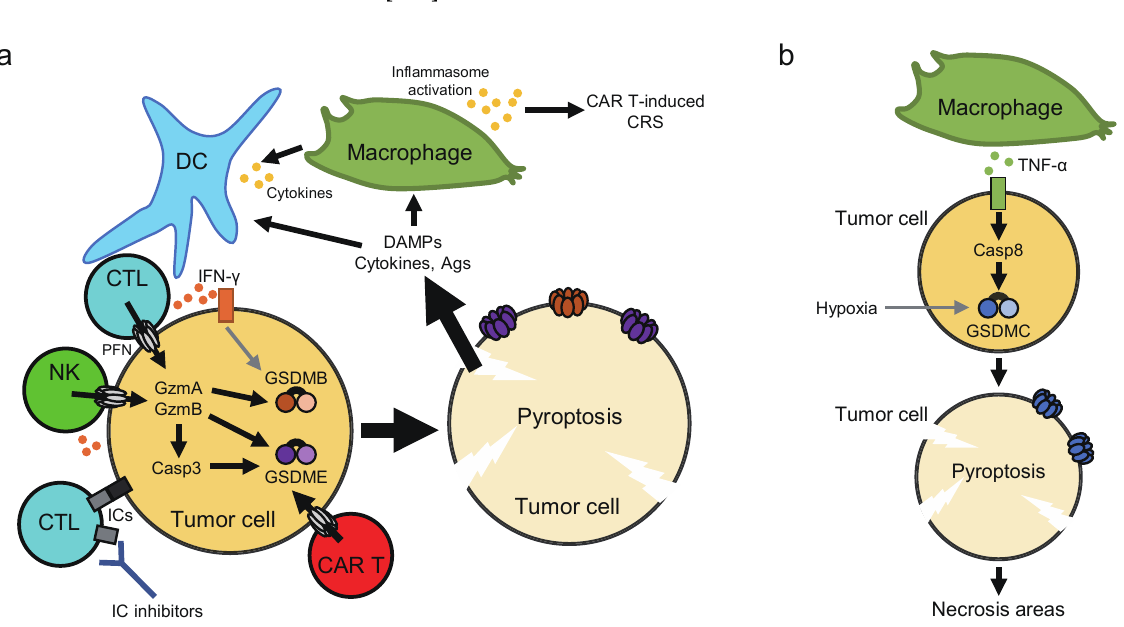
Figure 5. Effects of pyroptosis on the tumor microenvironment. ( a ) With the aid of perforin (PFN), Granzyme A/B (GzmA/B) are delivered from cytotoxic lymphocytes into the cytoplasm of target cancer cells. These Gzms activate GSDMB/E directly or by inducing caspase-3 (Casp3) activation, leading to tumor cell pyroptosis. Pyroptotic tumor cells also appear to activate the tumor microenvironment toward an immunostimulatory state probably through release of DAMPs and cytokines, forming a positive feedback loop in antitumor immunity. These effects of pyroptosis may synergize with immune checkpoint (IC) inhibitors. GSDMB expression is upregulated by IFN-γ. Massive tumor cell pyroptosis induced by CAR T therapy may cause CRS, which depends on a significant release of ATP and consequent activation of the NLRP3 inflammasome in host macrophages. ( b ) The expression of GSDMC is increased by hypoxia. Macrophage-derived TNF-α induces pyroptosis in tumor cells through the caspase-8-GSDMC pathway. This may account for the formation of necrotic areas found in central hypoxic regions of solid tumors. The sustained induction of pyroptosis in a small population of tumor cells may also induce chronic inflammation that promote tumor progression.